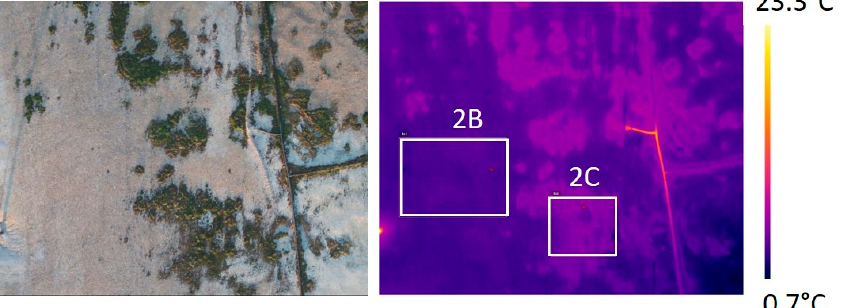
Figure 8. Visible (RGB) and infrared (IR) images of a central landfill area (with bare soil and low vegetation), acquired during the winter survey (February 2020) of Scala Erre.